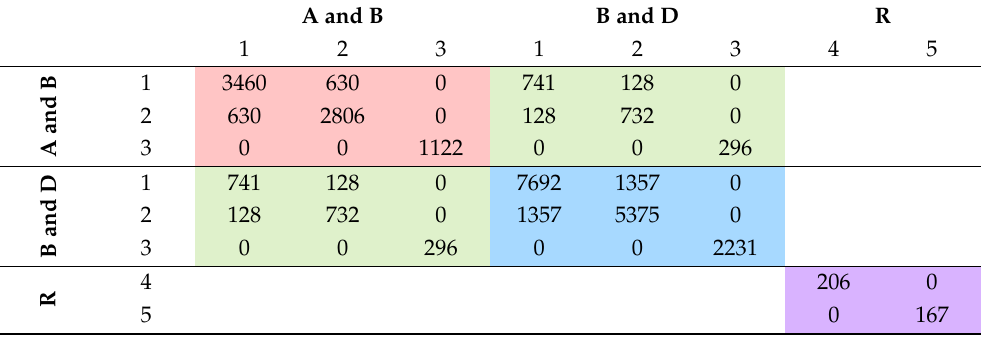
Table 3. Constitutive stiffness matrix H k for the XX-0-00 model. A and B